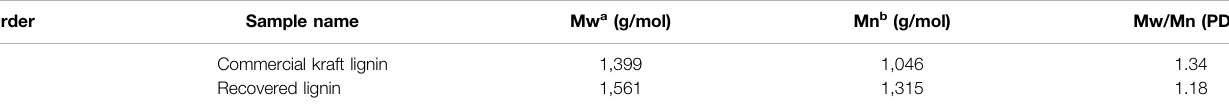
TABLE 3 | Molecular weight analysis of the commercial kraft lignin and recovered lignin.